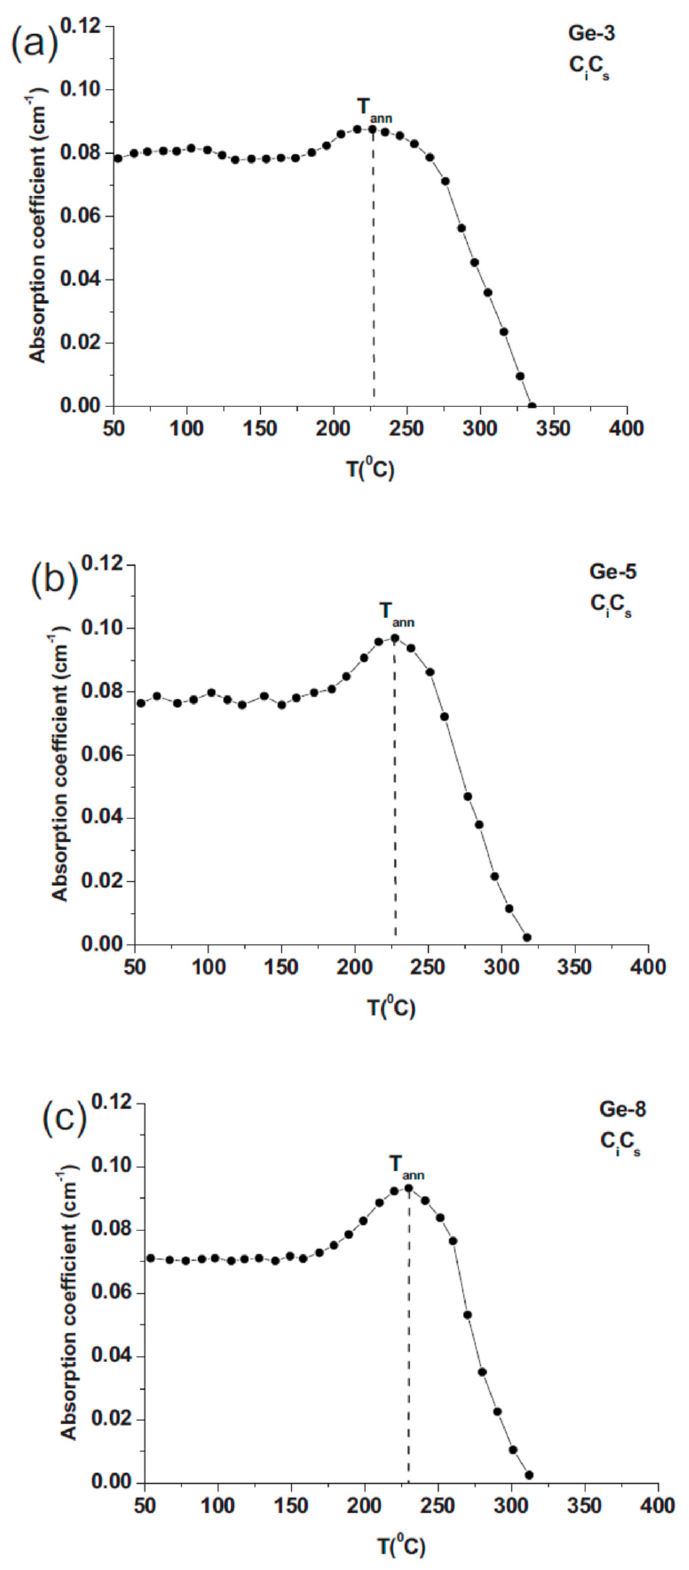
Figure 24. The evolution with T of the C i C s defect as a function of the Ge concentration for the ( a ) Ge-3, ( b ) Ge-5, and ( c ) Ge-8 samples. Reproduced with permission from [128]. American Institute of Physics, 2010.